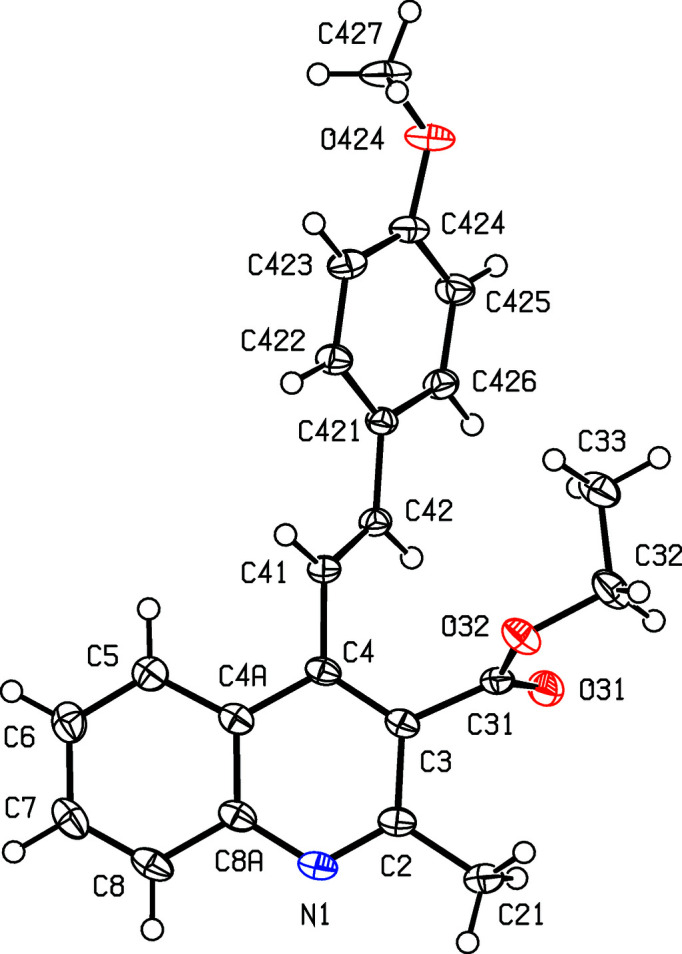
The mol­ecular structure of com­pound (IV), showing the atom-labelling scheme. Displacement ellipsoids are drawn at the 50% probability level.